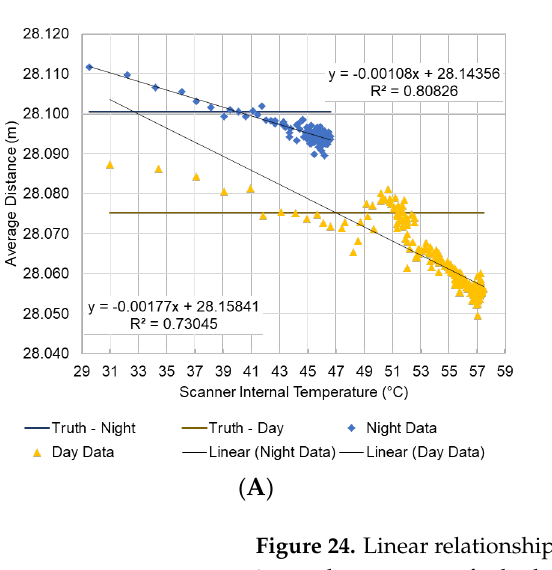
( D ) Figure 23. Weather conditions during Velodyne ® HDL–32E night and day absolute accuracy exper- iments: ( A ) air temperature (°C), ( B ) barometric pressure (inches of mercury), and ( C ) solar radiation (watts per square meter) at study site. ( D ) Comparison between solar radiation and measured dis- tance. The higher air temperature of the day iteration versus the night iteration was ex- pected (Figure 23A), and was associated with the higher scanner temperature of the day iteration shown in Figure 20A. The solar radiation results identify a phenomenon where